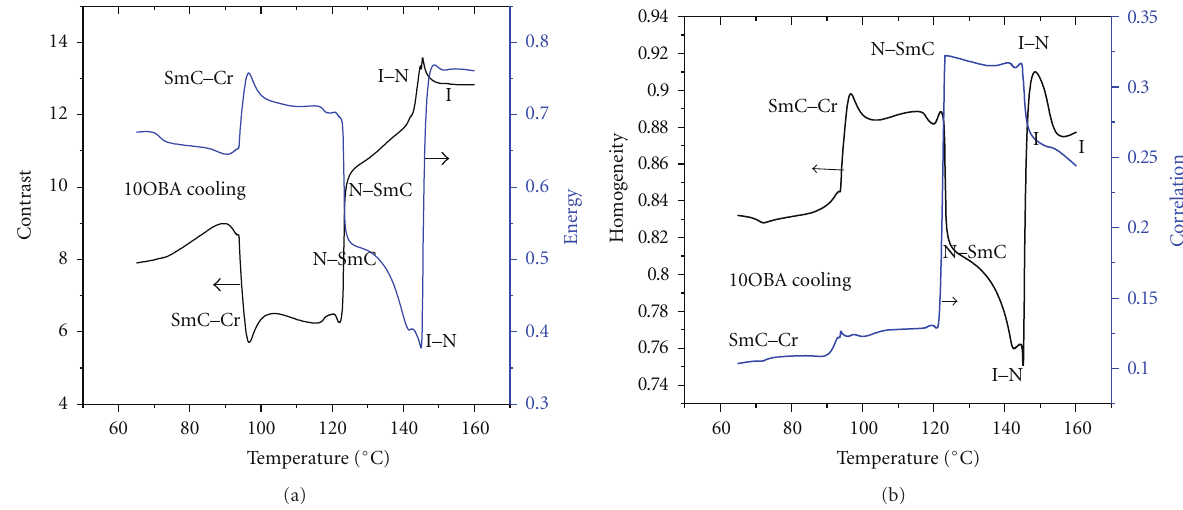
Figure 8: Computed parameters from the textures of 10OBA as a function of temperature where the phase transitions are indicated. (a) Contrast and energy; (b) homogeneity and correlation.